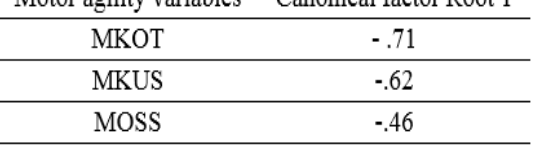
Table 5. The structure of statistically significant canonical factors in the system of motor variables from the agility